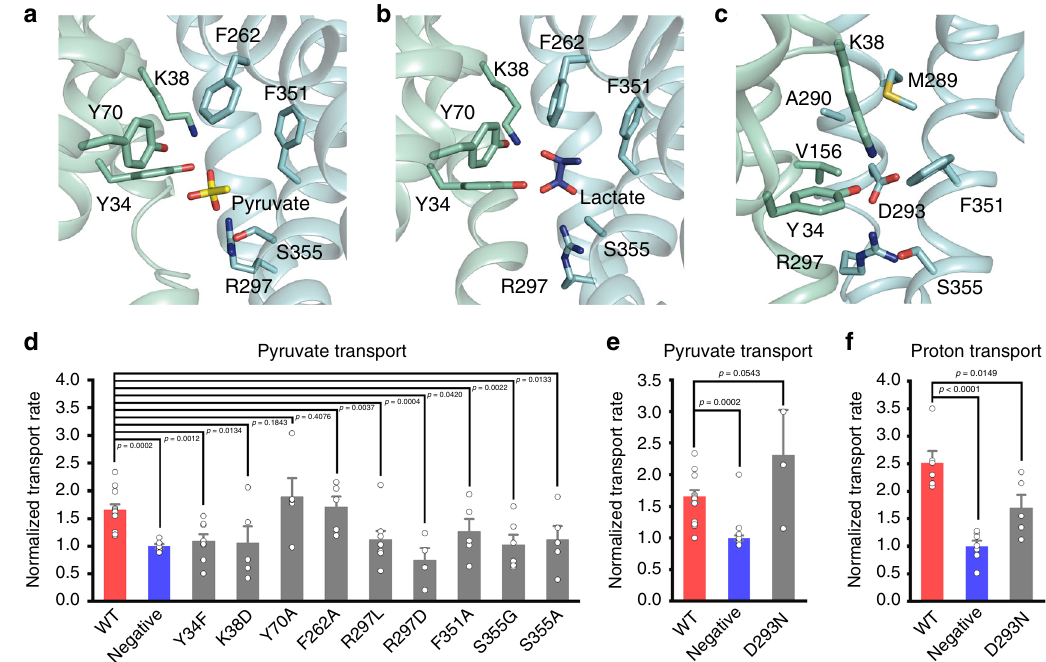
Fig. 4 Implications for substrate recognition and proton coupling. a , b Binding con fi gurations of a, pyruvate or b, L-lactate in the MCT2 central cavity from docking studies. Details of the docking experiments can be found in Supplementary Methods. c Zoom in view of the MCT2 central cavity showing the residues around Asp293. a – c The protein is colored in cyan with corresponding residues and substrates shown in stick. d The pyruvate in fl ux rates of HEK293T cells transformed with MCT2 variants. Wild type (WT) MCT2 and empty vectors were used as positive and negative controls. Bar plots depicting normalized rates of pyruvate in fl ux (WT MCT2, n = 12; Negative, n = 6; Y34F, n = 8; K38D, n = 5; Y70A, n = 5; F262A, n = 5; R297L, n = 8; R297D, n = 4; F351A, n = 5; S355G, n = 6; S355A, n = 5). e, The pyruvate or f, the proton in fl ux rates of HEK293T cells transformed with MCT2 variants. Bar plots depicting normalized rates of pyruvate or proton in fl ux (for pyruvate in fl ux, WT MCT2, n = 12; Negative, n = 6; D293N, n = 3; for proton in fl ux, WT MCT2, n = 6; Negative, n = 7; D293N, n = 5). Bar plots data were presented as mean ± SEM. One-tailed t